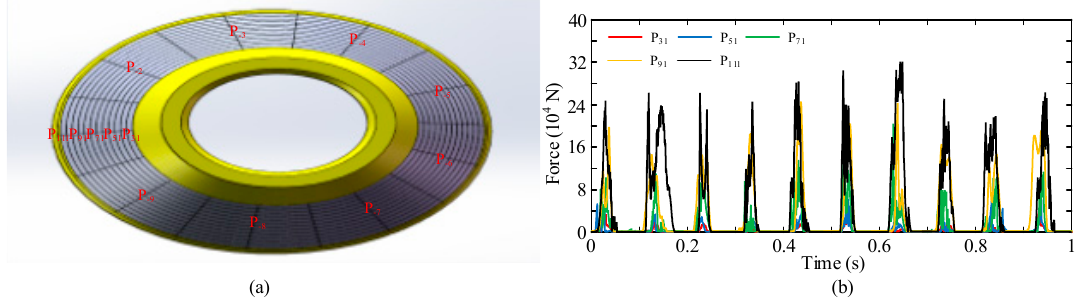
Figure 21. Locations and numbers of the areas ( a ) F n acting on P 31 , P 51 , P 71 , P 91 , and P 111 for 1 s of operation ( b ).